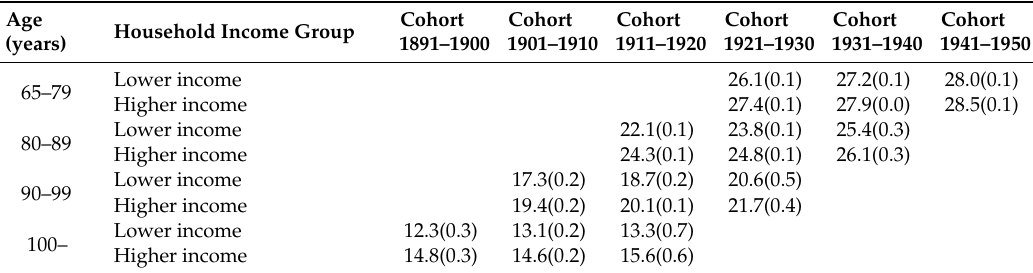
Table 3. The scores of cognitive functions by di ff erent income among older adults a .